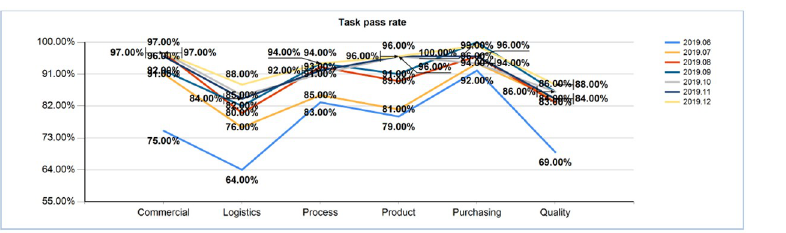
Fig 9. Monthly post functional task closing rate